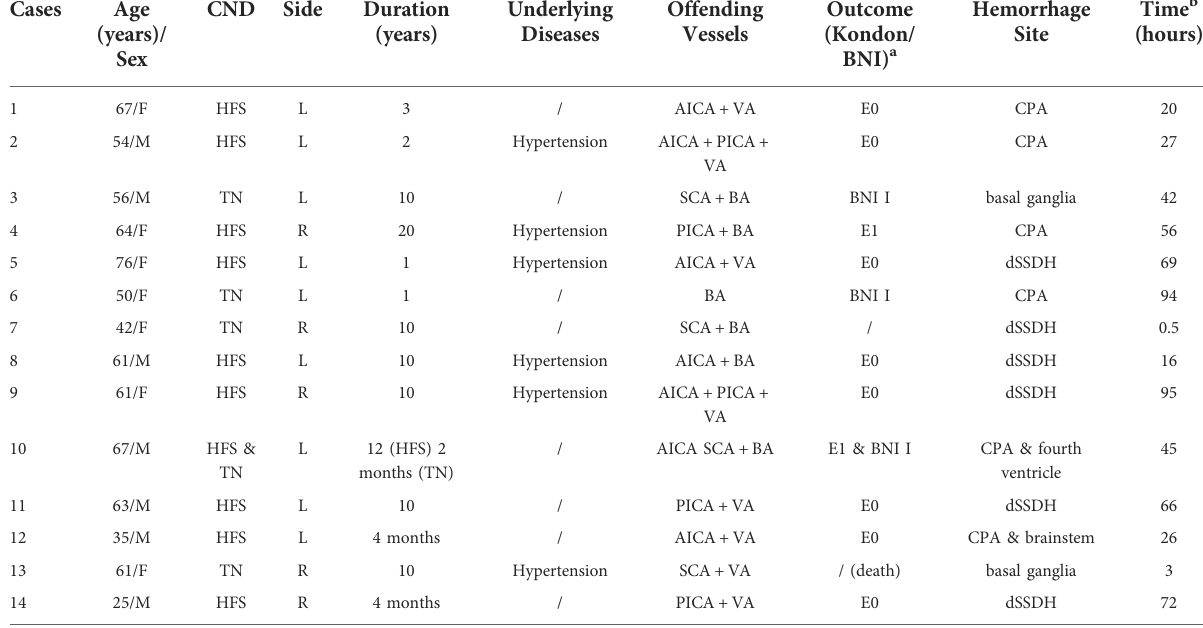
TABLE 1 Summary of 14 cases with postoperative hemorrhage. Cases